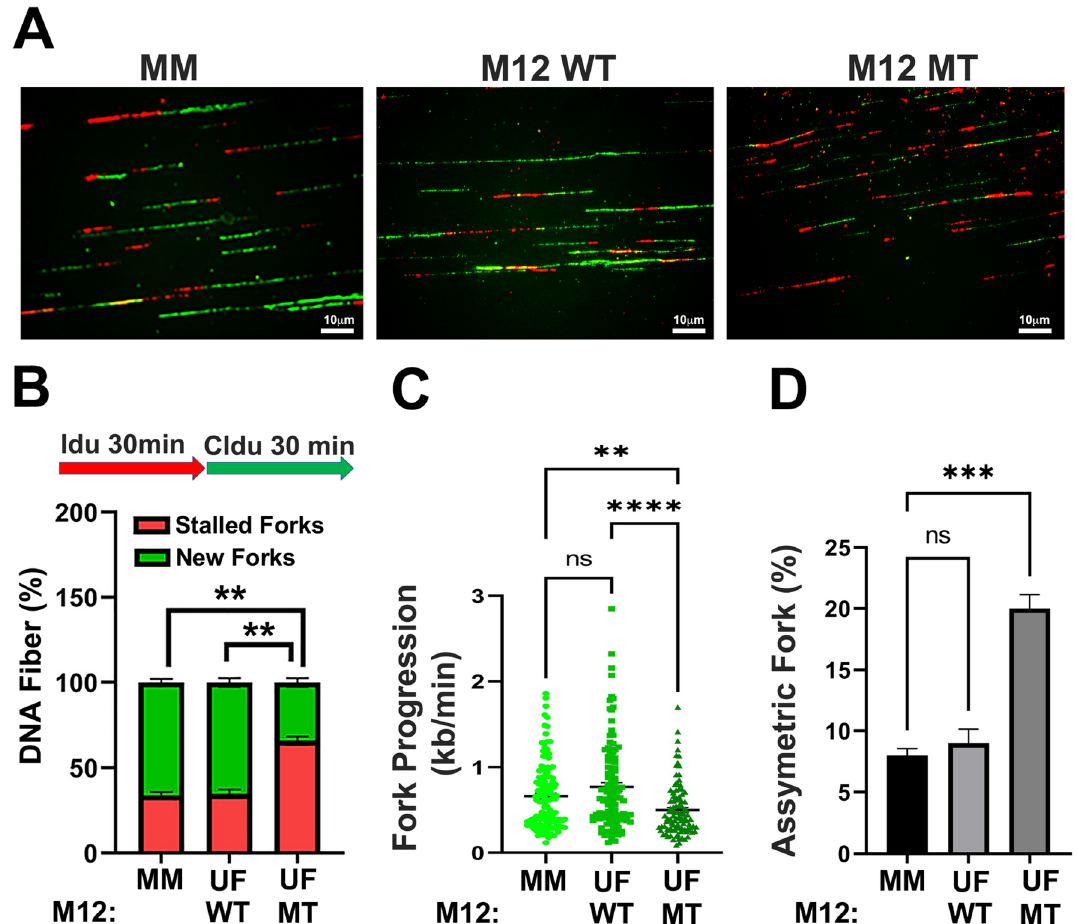
Figure 2. MED12-mutant UFs are characterized by replication stress. ( A ) Representative images of combed DNA fibers from primary MM and UF cells pulse-labeled with thymidine analogues IdU (red) and CldU (green). The MED12 mutation status of UF cells [MED12 WT (M12 WT) or MED12-mutant (M12 MT)] is indicated. ( B ) Top, pulse labeling scheme. Bottom, percentage of singly labeled fibers retaining only first (Idu) or second (CldU) label indicative of stalled or new forks, respectively. ( C ) Velocity of fork progression as determined from ldU tract lengths (kb/min). ( D ) Percentage of bidirectional asymmetric forks, represented as percentage of forks relative to total number of forks in the field. Statistical significance was calculated using One- Way ANOVA followed by Tukey’s Post hoc test, **** p ≤ 0.0001, *** p < 0.001; ** p < 0.01. ns, not